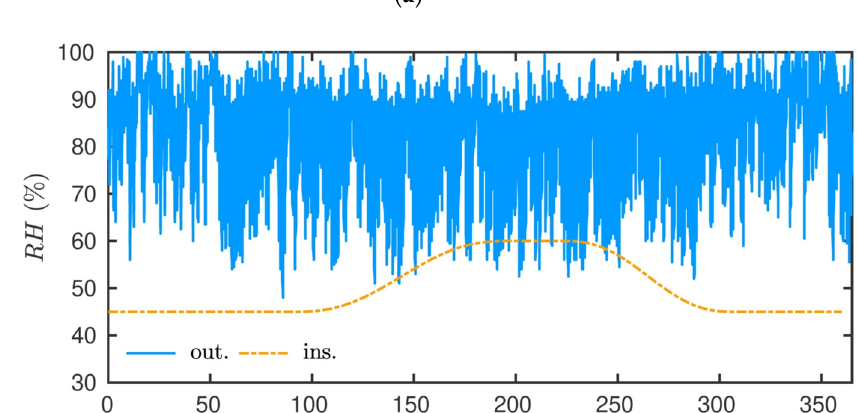
Relative humidity. ( b ) Relative